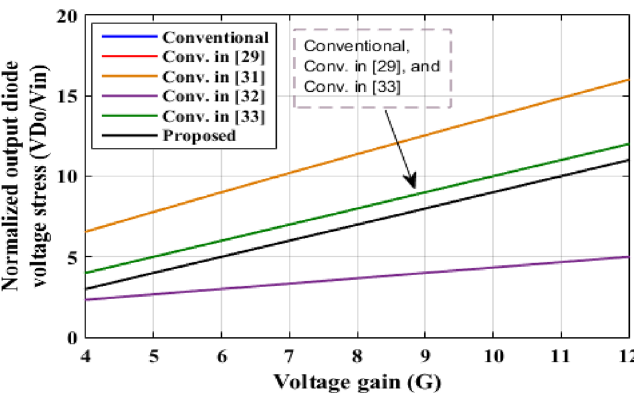
Figure 22. Normalized output diode voltage stress with voltage gain